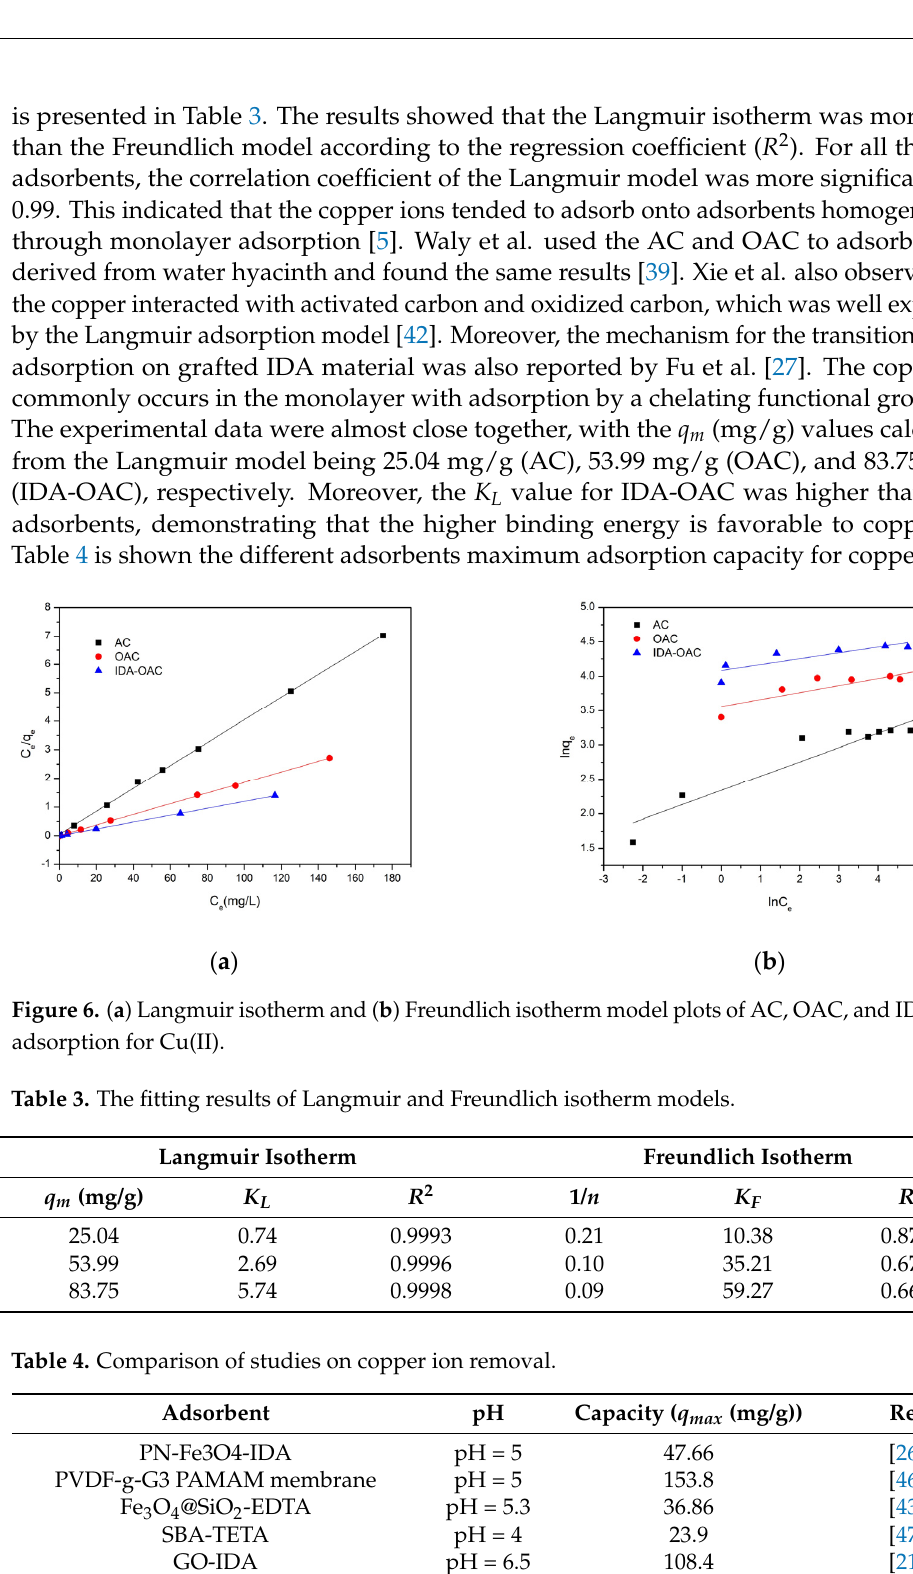
( b ) Figure 5. The adsorption capacity ( a ) and the removal efficiency ( b ) for AC, OAC, and IDA-OAC in the different initial concentrations.